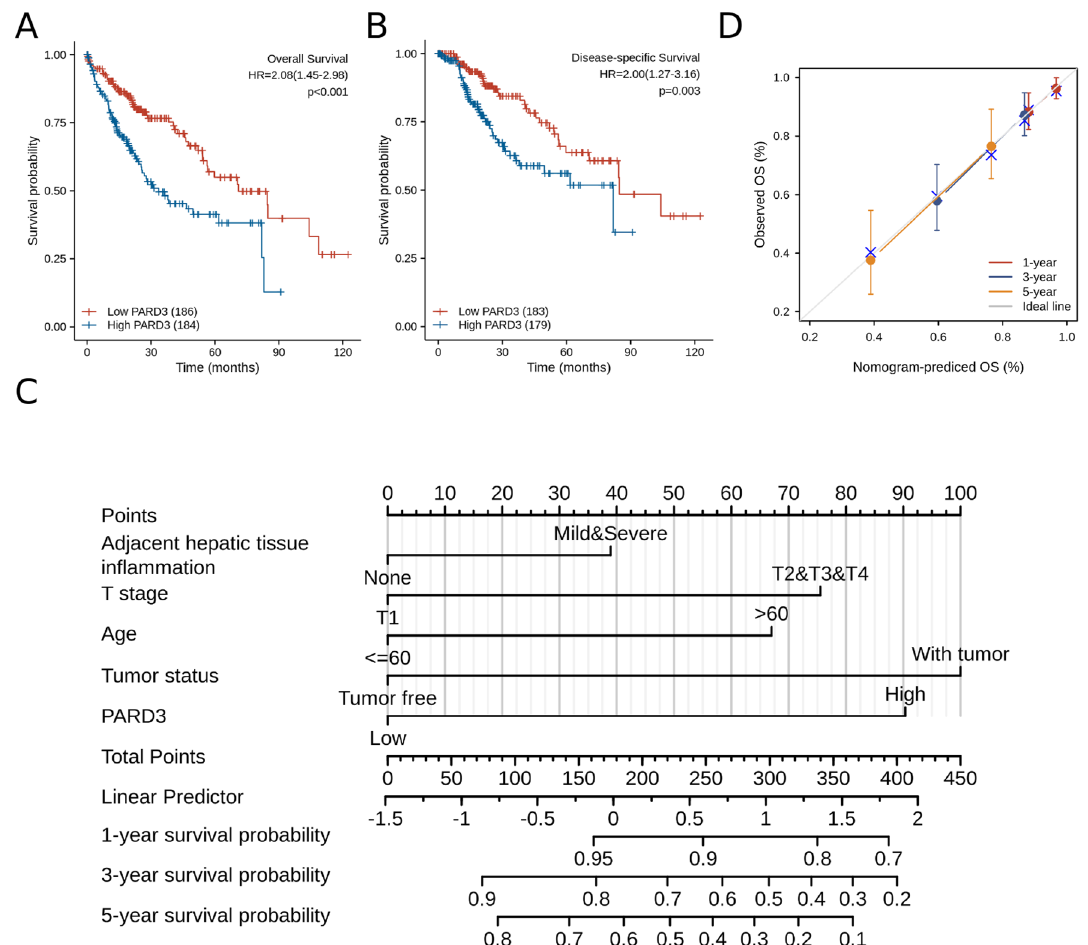
Figure 3. Impact of PARD3 expression on survival in HCC patients. ( A ) Overall survival (OS) was significantly higher in low PARD3 expression group (HR = 2.08, 95% CI = 1.45–2.98, p < 0.001); ( B ) Disease-specific survival (DSS) was significantly higher in low PARD3 expression group (HR = 2.00, 95% CI = 1.27–3.16, p = 0.003); ( C ) Nomogram for prediction of OS in HCC patients (existing adjacent hepatic tissue inflammation, T2–T4 stage, age > 60 years, with tumor, and high PARD3 expression were converted into 39, 75.5, 67, 100 and 90.25 points, respectively. The total points accumulated by the above covariates correspond to the predicted probability for an HCC patient); ( D ) Calibration curve of the